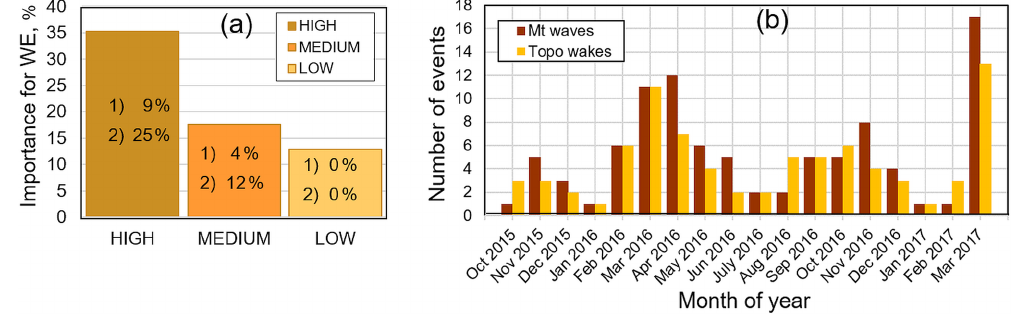
Figure 3. (a) Distribution of days during WFIP2 that exhibited observed phenomena that were ranked as of high, medium, and low im- portance to wind energy according to the event log. The frequency of cases per level of importance that are considered a potential (1) or interesting or relevant (2) case for wind energy is given in each bar. (b) Distribution of mountain waves and topographic wakes observed during WFIP2 according to the event